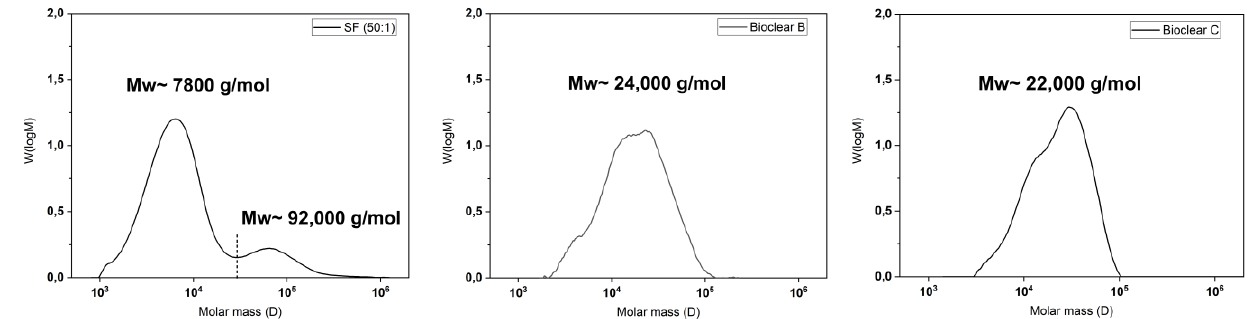
Figure 1. Gel-permeation chromatography (GPC) elution spectrums of normalized distributions vs. molar mass of components of SF, Bioclear B, and Bioclear C showing the average molecular weight of free oligomers. All substrates were cured for 4 h at 65 °C and consecutively placed in THF to elute the unreacted species. For comparison, the individual components of the PDMS types prior to mixing were analyzed (see Figure A1). In the case of SF, the result shows the loss of low-molecular weight species (7800 g/mol) and high-molecular weight species (92,000 g/mol). The dashed line represents the integration limit. In the case of the Bioclear types, the results show medium molecular weight (24,000 g/mol and 22,000 g/mol, respectively).